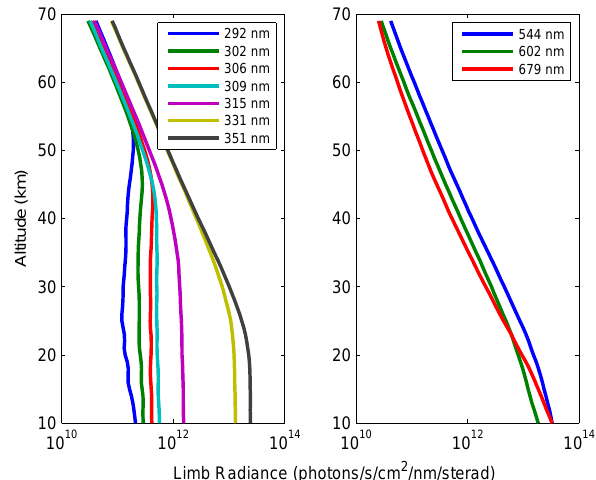
Fig. 1. A sample set of OSIRIS limb radiance profiles used for the ozone retrieval. Measurements within the Hartley-Huggins band and Chappuis band are shown in the left and right panels respec-